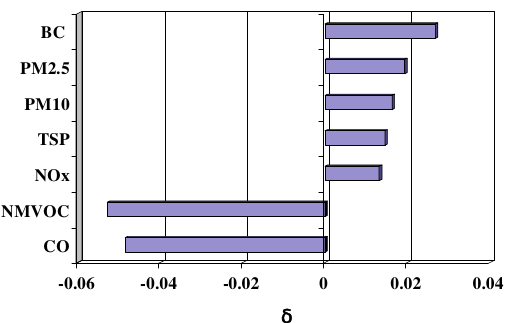
Fig. 18. The relative difference of average energetic index of pollutant emission from motor vehicles in Poland comparing 2015 to 2016